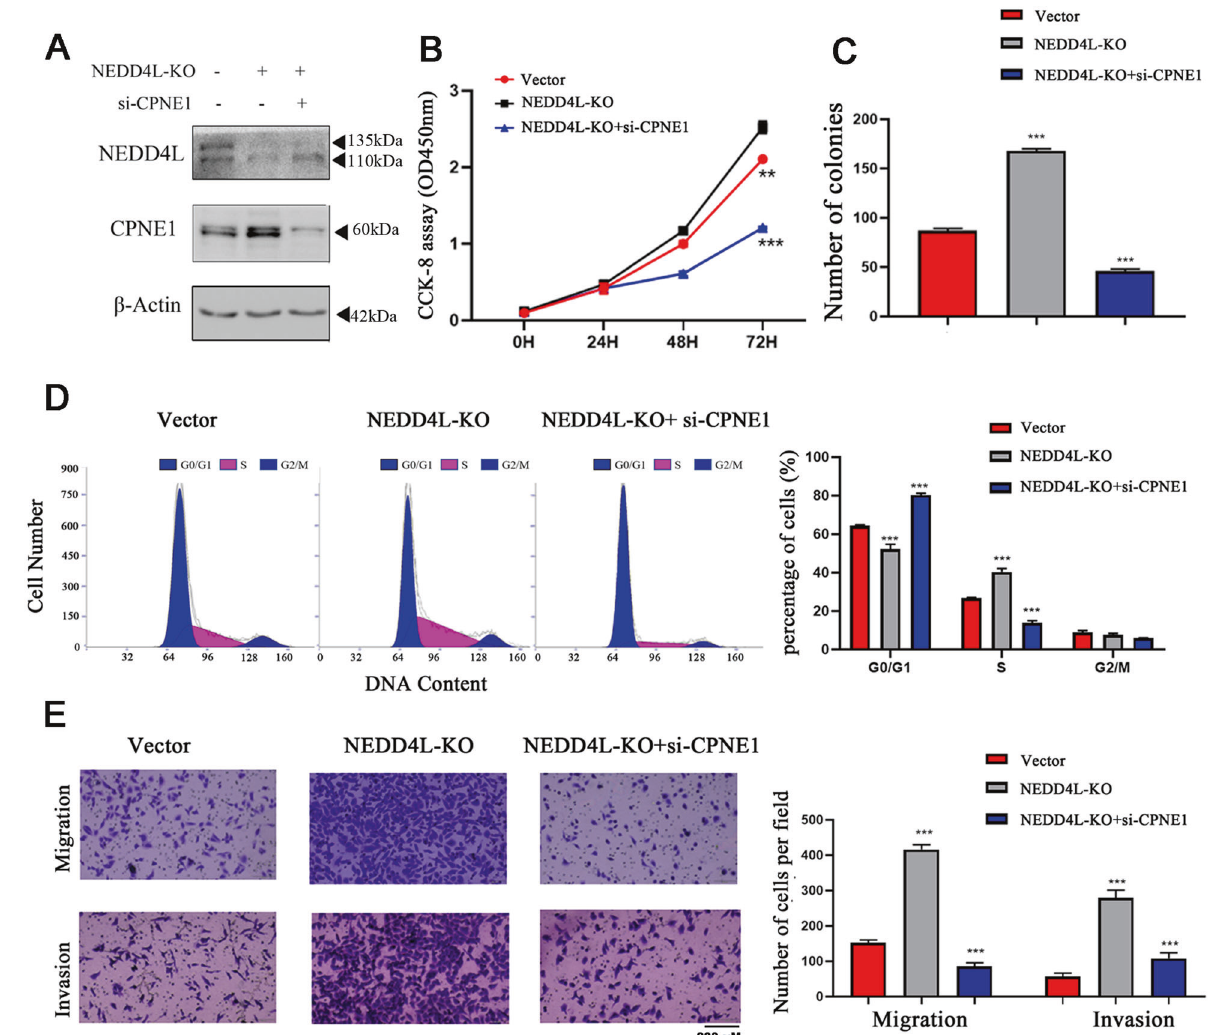
Fig. 6 NEDD4L knockout promotes tumor cell proliferation and metastasis through CPNE1. A CPNE1 protein levels in NEDD4L-KO/ NEDD4L-KO NSCLC cells and NSCLC cells with CPNE1 interference. B CCK-8 assay of cell viability in A549 cells. C Representative images showing the results of clonogenic assays of cell proliferation in A549 cells. Bar charts showing the colony formation of cells. D Flow cytometric assay of A549 cells. Cells were harvested 72 h after transfection and stained with PI. The percentage of cells in each cell cycle phase is shown in the inset of each panel. E Representative images showing the results of transwell cell migration and invasion assays in A549 cells. ** P < 0.01; *** P <